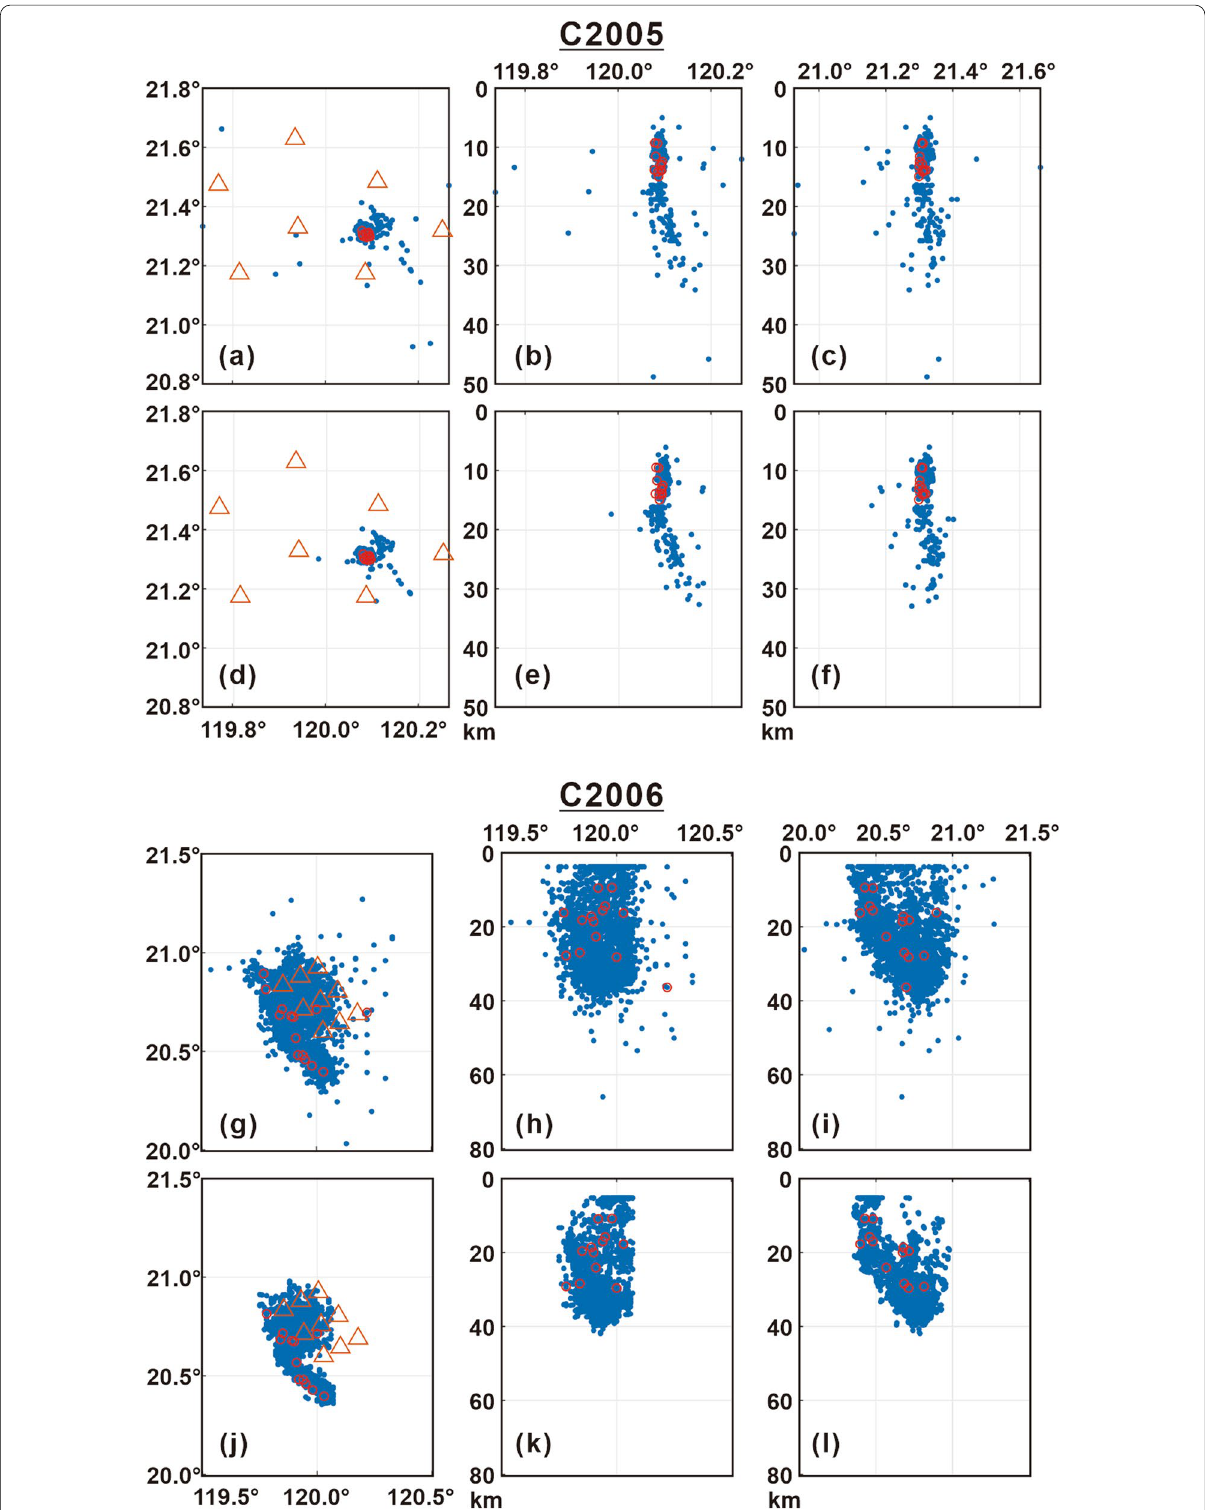
Fig. 4 Initial locations ( a , b , c , g , h , i ) and relocations ( d , e , f , j , k , l ) of the earthquake sequences detected in the present study. The circles outlined in red indicate the events of magnitude larger than 3.0. The OBS stations are presented in red